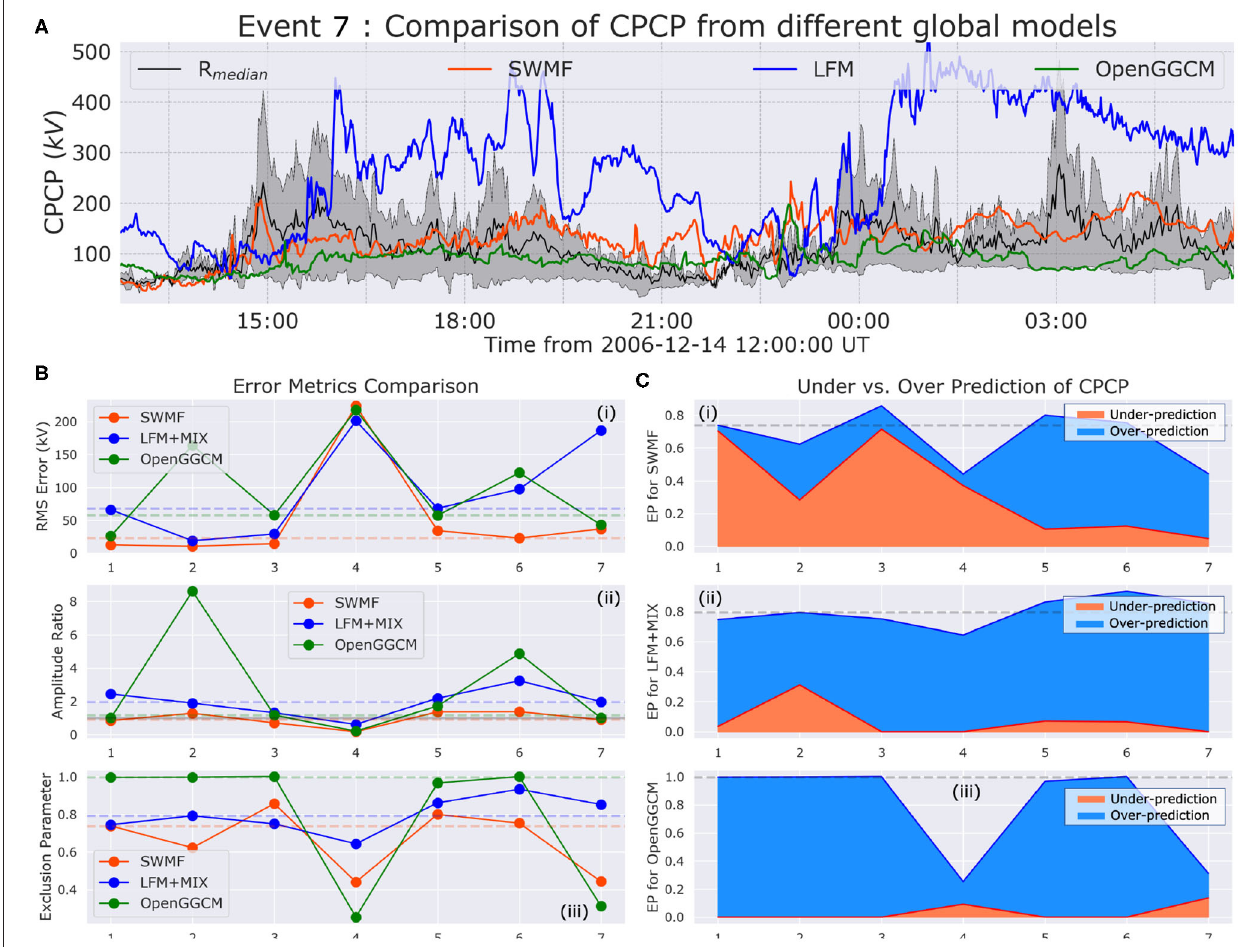
FIGURE 2 | Analysis of the MHD-predicted cross polar cap potential (CPCP) against AMIE and SuperDARN estimates – (A) An example time-transient comparison of the CPCP during Event 7 from SWMF (in red), LFM+MIX (in blue), and OpenGGCM (in green) compared against the combined range of values between AMIE and SuperDARN estimates demarcated here by the gray band, with the black line in the center of the band being the median value. Formats for subplots (B,C) are similar to Figures 1B,C